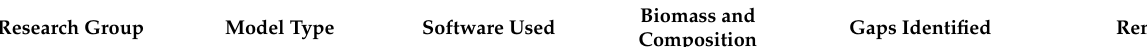
Table 1. Summary of available HTC computational models in the